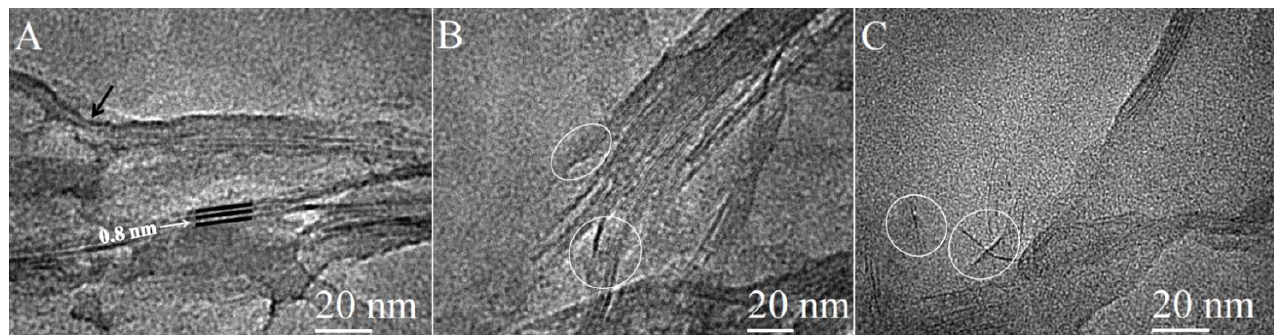
Figure 4. TEM images of NG-MMT 3:1.